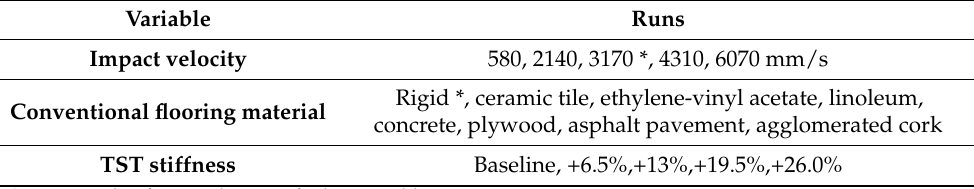
Table 1. Simulated variables. Variable Runs Impact velocity 580, 2140, 3170 *, 4310, 6070 mm/s Rigid *, ceramic tile, ethylene-vinyl acetate, linoleum, Conventional flooring material concrete, plywood, asphalt pavement, agglomerated cork TST